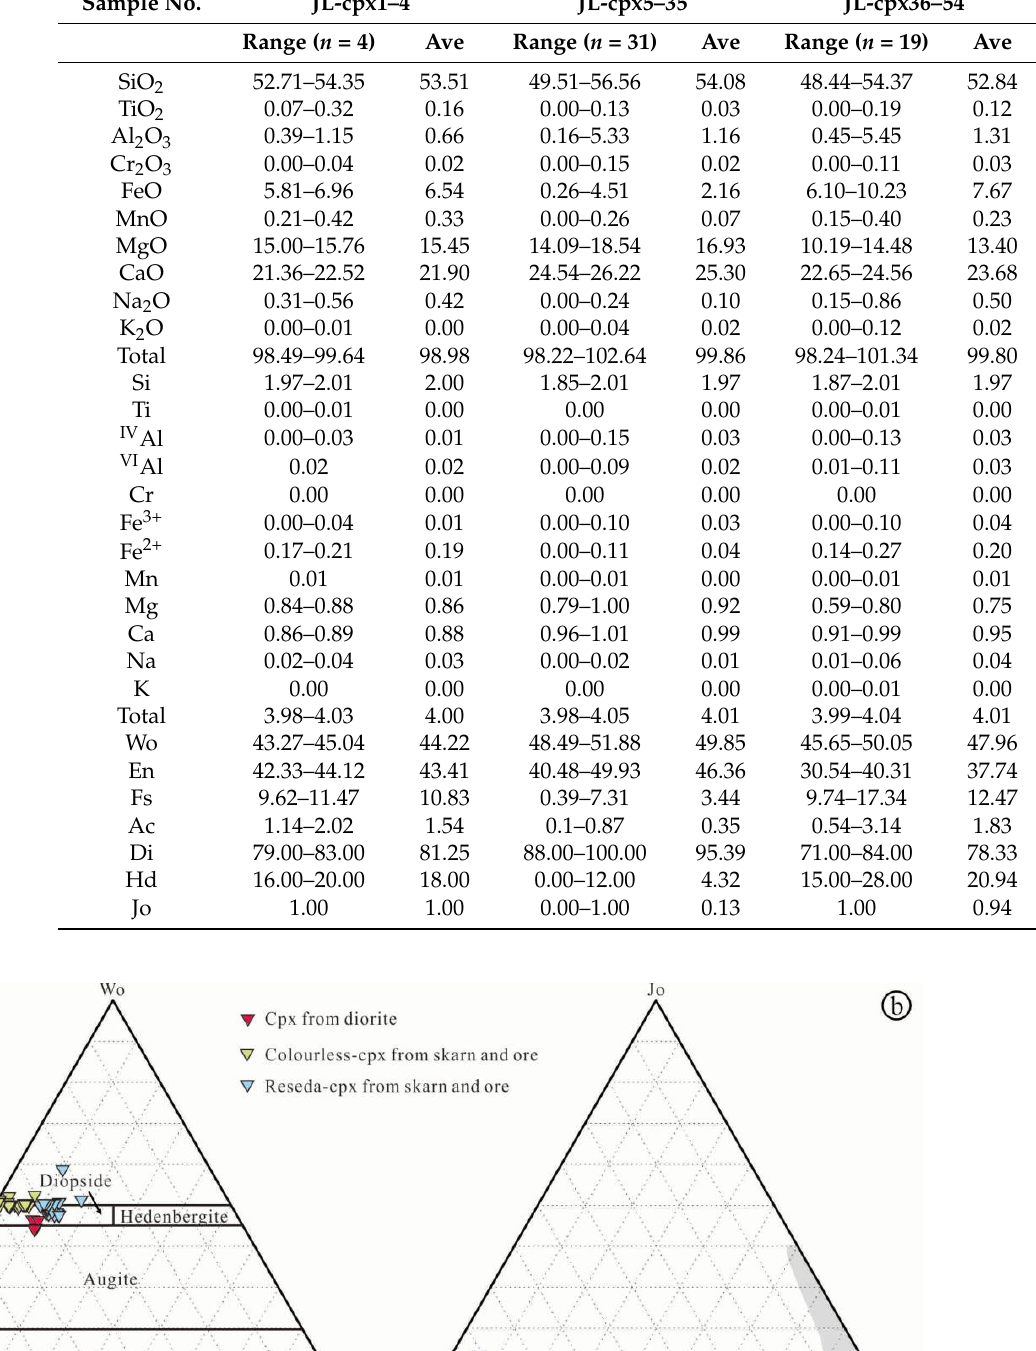
Table 2. Average composition and compositional range of EPMA data for clinopyroxenes from Jinling diorites (JL-cpx1–4), skarn, and ore (JL-cpx5–54, samples JL-cpx5–36 are colorless and samples JL-cpx37–54 are light-green in the Figure 7a).